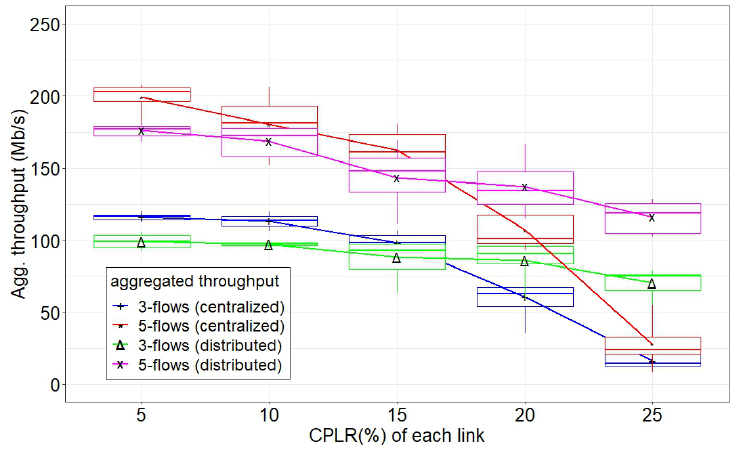
Figure 6. Data plane performance metric (aggregated throughput) comparison between centralized and distributed operations, during unreliable control plane conditions in a 16-node grid